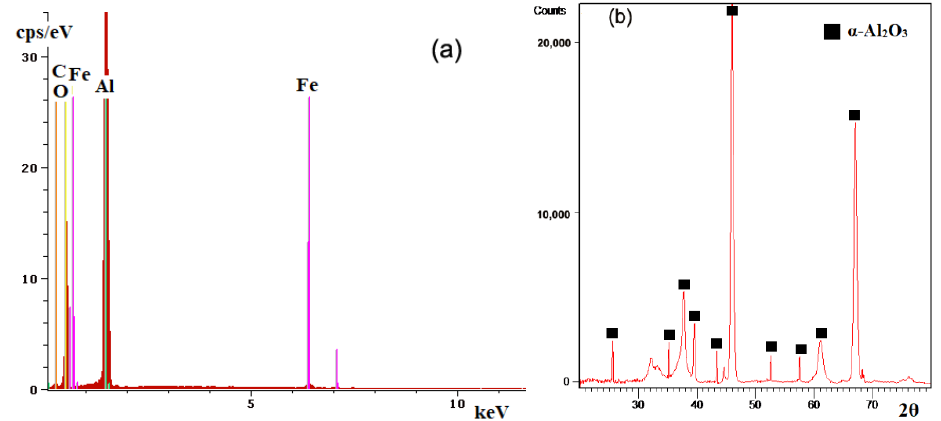
Figure 3. Chemical analysis of the ceramic coatings deposited on the metallic substrate. ( a ) EDS spectrum; ( b ) XRD spectrum.